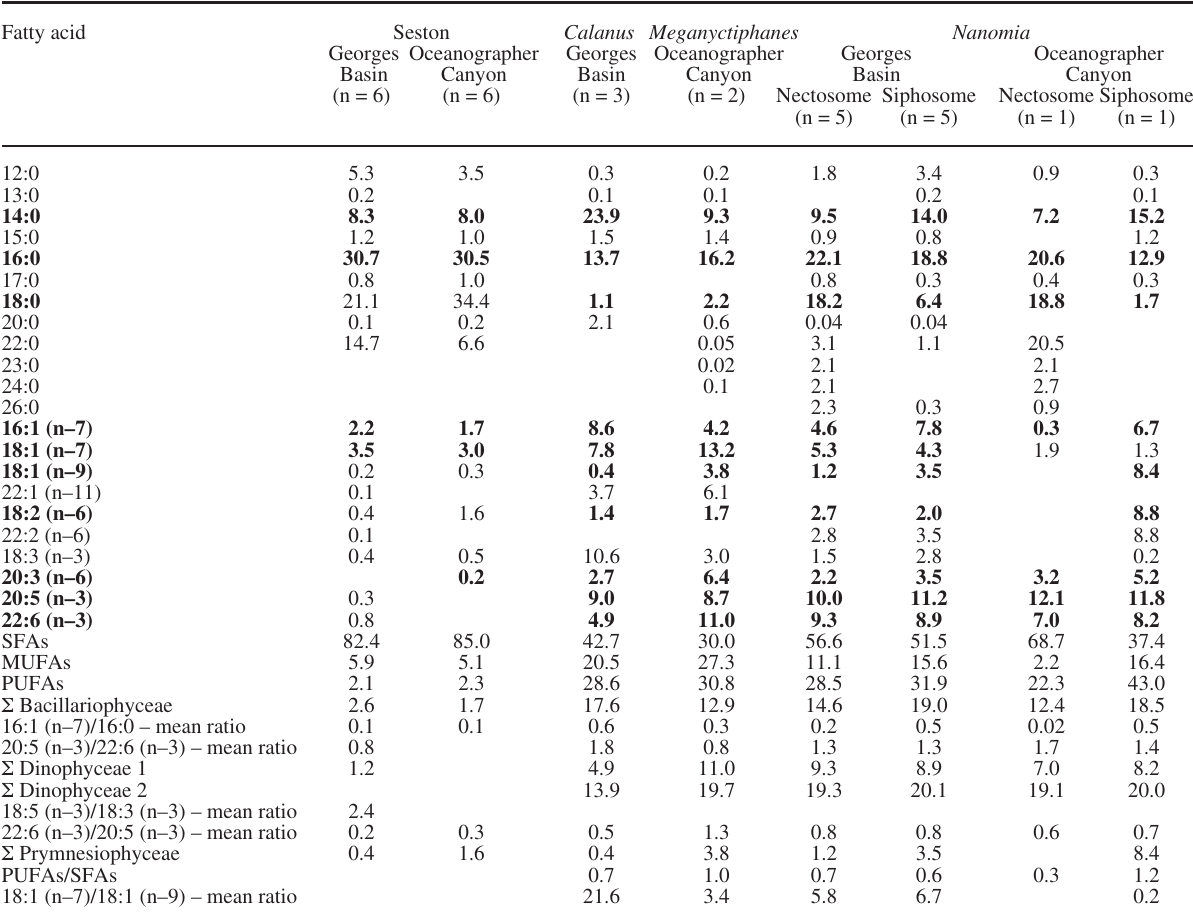
Table 4. – Mean fatty acid concentrations as percentages of the total fatty acid pool, with potential trophic markers in bold. Σ bacillariophyc- eae, sum of 16:1 (n–7), 16:4 (n–1) and 20:5 (n–3); Σ Dinophyceae 1, sum of 18:5 (n–3) and 22:6 (n–3); Σ Dinophyceae 2, sum of 20:5 (n–3) and 22:6 (n–3); Σ Prymnesiophyceae, sum of 18:1 (n–9) and 18:4